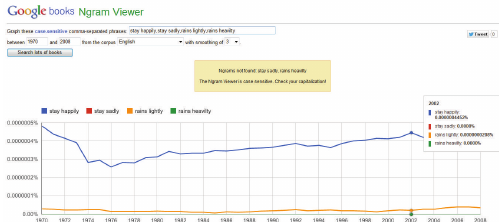
Figure 2: Google 𝑛 -gram Viewer showing the most commonly found adverbs modifying their